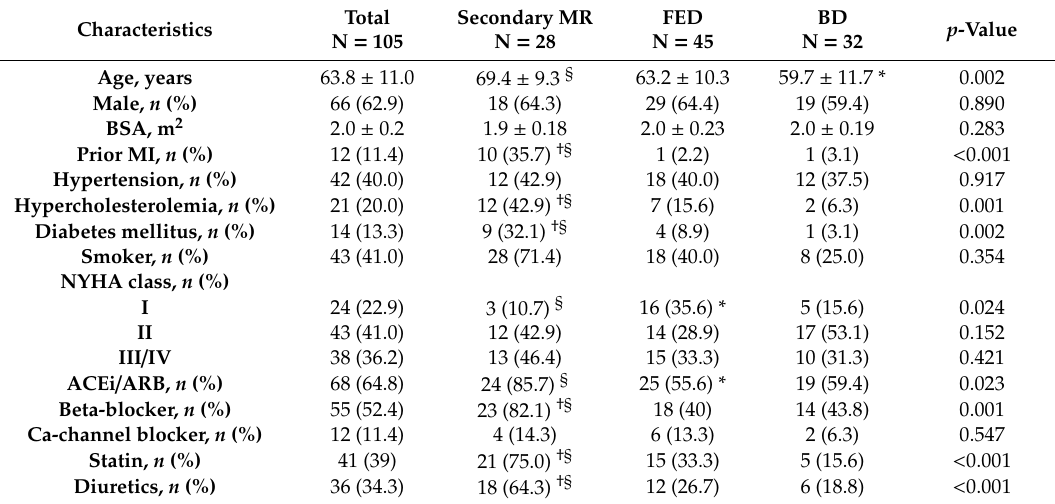
Table 1. Clinical